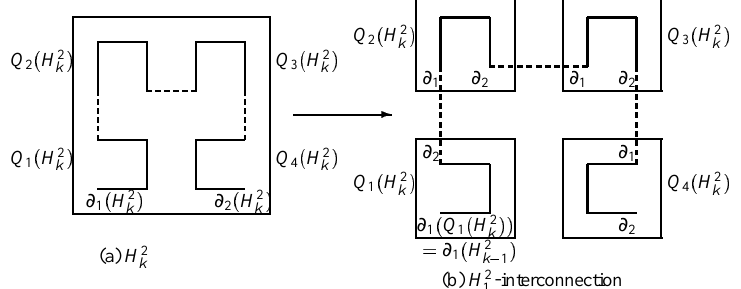
-subcurves in 1 k (cid:0)